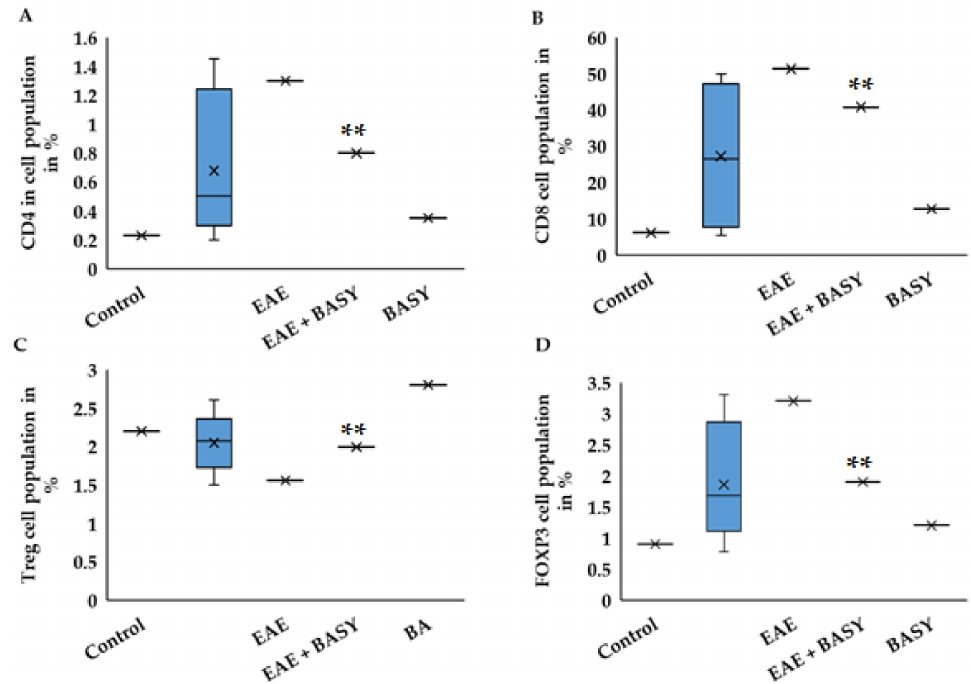
Figure 4. BASY activates the Treg cell population and the EAE condition by controlling CD4 polariza- tion. ( A – D ) absolute number of infiltratedCD4, CD8, Treg and FOXP3 positive cells within the CNS of the control, EAE, EAE+BASY, and BASY pretreated MOG-immunized mice groups, respectively. The cells were sorted using the Miltenyi cell separation kit and the total population was counted using the Thermos cell counter. Incidence bars in each graph are expressed as the upper and lower limit of cell population in CNS of EAE and BASY with EAE mice groups. Data were pooled from three independent experiments and shown as mean ± SD. ** p < 0.01.